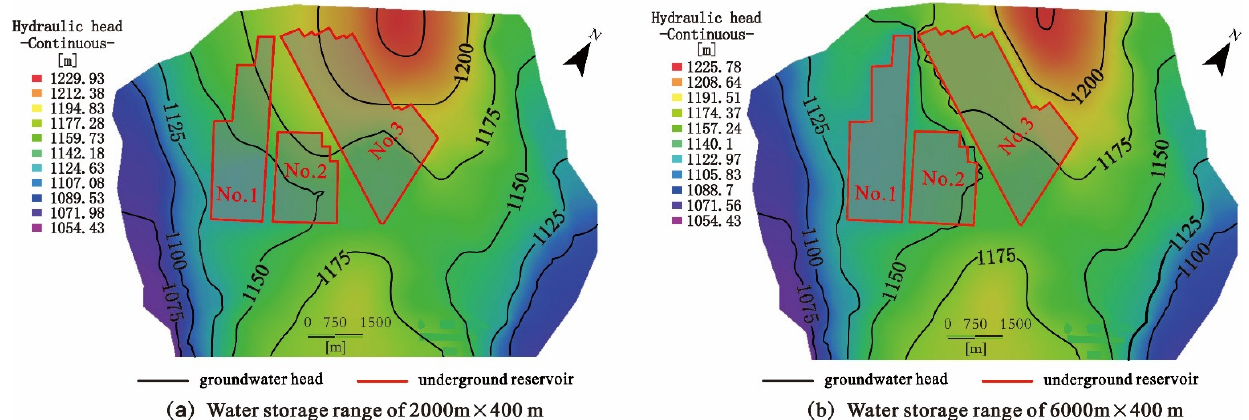
Figure 15. Groundwater contour map of the lower aquifer system under different water-storage ranges: ( a ) 2000 × 400 m, ( b ) 6000 × 400 m.